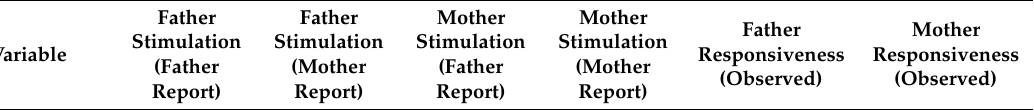
Table 2. Correlation matrix of reported measures of paternal and maternal stimulation and observed measures of paternal and maternal